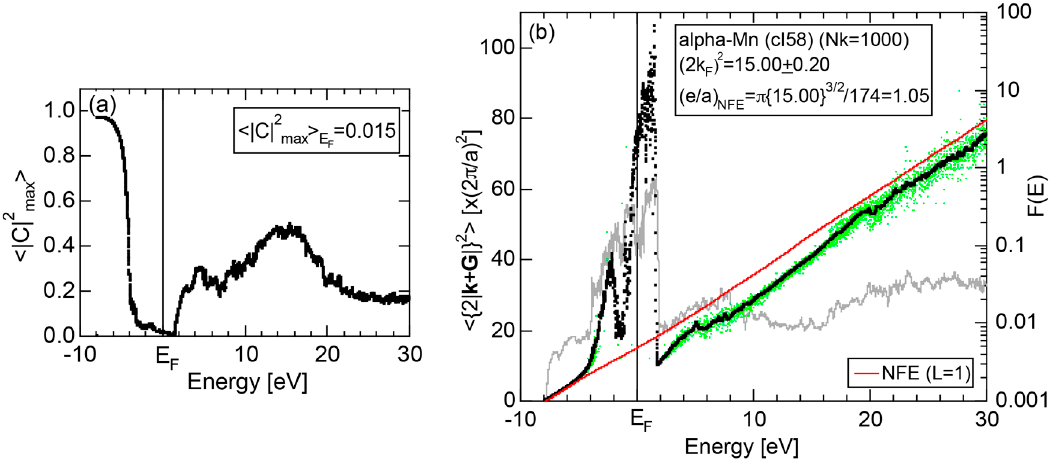
(cid:69) (cid:68) and ( b ) Hume-Rothery plot for α -Mn (cI58). See captions of Figure 19 (b) for Figure 26. ( a ) C max2 | C | 2 Figure 26. ( a ) and ( b ) Hume-Rothery plot for α -Mn (cI58) [11]. See captions of Figure 19b for max E E symbols in symbols in ( b ).